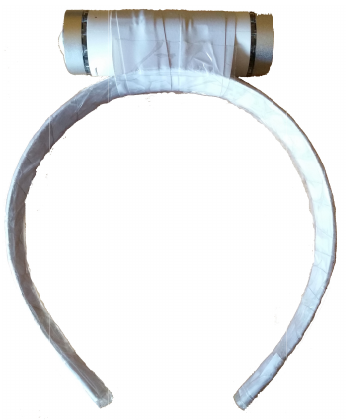
Figure 2. Node + sensor platform setup for head tremor assessment.